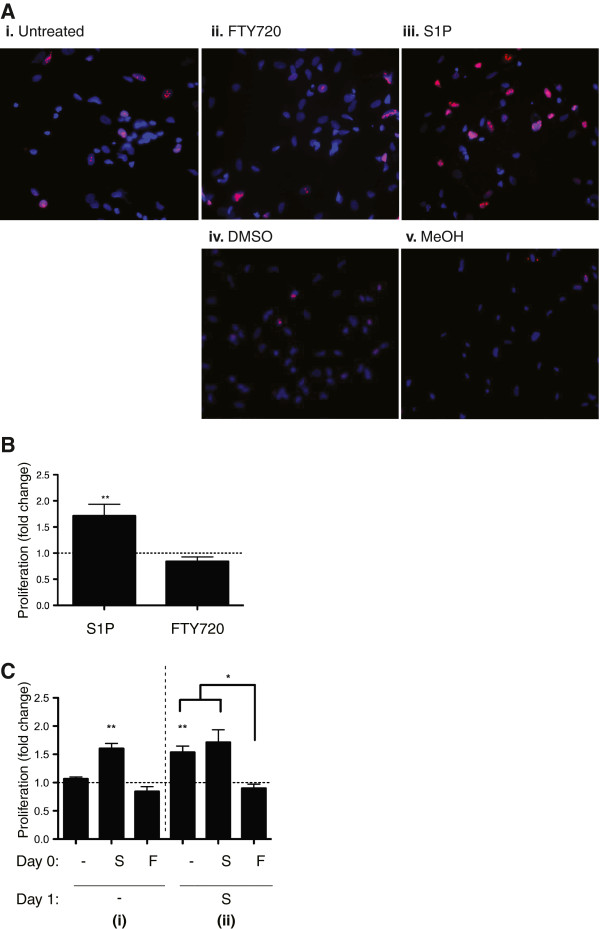
(A) Human fetal astrocyte proliferation in response to S1P receptor ligands. Immunocytochemistry stains for astrocytes undergoing cell division (Ki-67, red) and cell nuclei (Hoechst nuclear stain, blue). (i) Untreated cells (basal proliferation). (ii) FTY720 (100 nM) overnight. (iii) S1P (100 nM) overnight. (iv) DMSO control. (v) Methanol control (MeOH). (B) Quantification of human fetal astrocyte proliferation in response to S1P receptor ligands. Proliferation indices were generated by determining the percentage of cells positive for Ki-67 relative to total cell population (Hoechst nuclear stain). Fold changes in proliferation were calculated relative to rate of proliferation under basal conditions. S1P induced a 1.8-fold increase in astrocyte proliferation, whereas FTY720 did not mediate proliferation beyond the basal rate (normalized to 1) (n = 3). (C) FTY720 pre-incubation blocks proliferative response of S1P on human fetal astrocytes. At outset (Day 0), astrocytes were either treated with S1P (S) or FTY720 (F). Following overnight culture, cells were either (i) left untreated (−) or (ii) incubated with S1P for another 24 h (Day 1). Proportion of astrocytes undergoing proliferation (Ki-67+) was then determined. Hoechst nuclear stain was used to determine total cell number. Proliferation fold change was calculated relative to rate of proliferation under basal conditions (normalized to 1). (i) S1P induced a 1.6-fold increase in astrocyte proliferation whereas FTY720 was comparable to basal proliferation rate. (ii) Significant proliferation (1.5-fold increase) was observed in untreated astrocytes (Day 0) when given S1P for 24 h (Day 1). S1P-pre-treated astrocytes on Day 0 continued to proliferate (1.8-fold increase), whereas FTY720 exposure on Day 0 did not result in astrocyte proliferation when exposed to S1P stimulation added on Day 1 (n = 3).